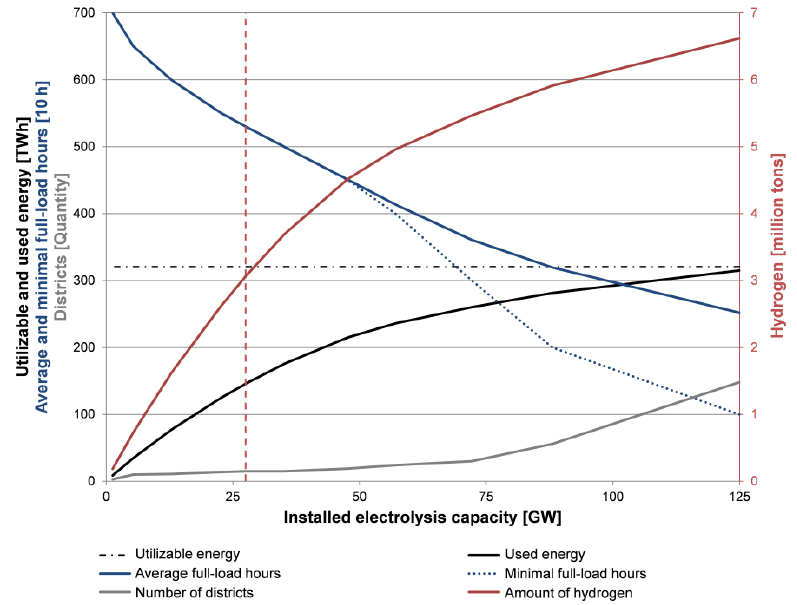
Figure 13. Utilizable and used energy, average and minimal full-load hours, quantity of districts and produced hydrogen, by use of an efficiency coefficient of 70% and increasing electrolysis capacity.